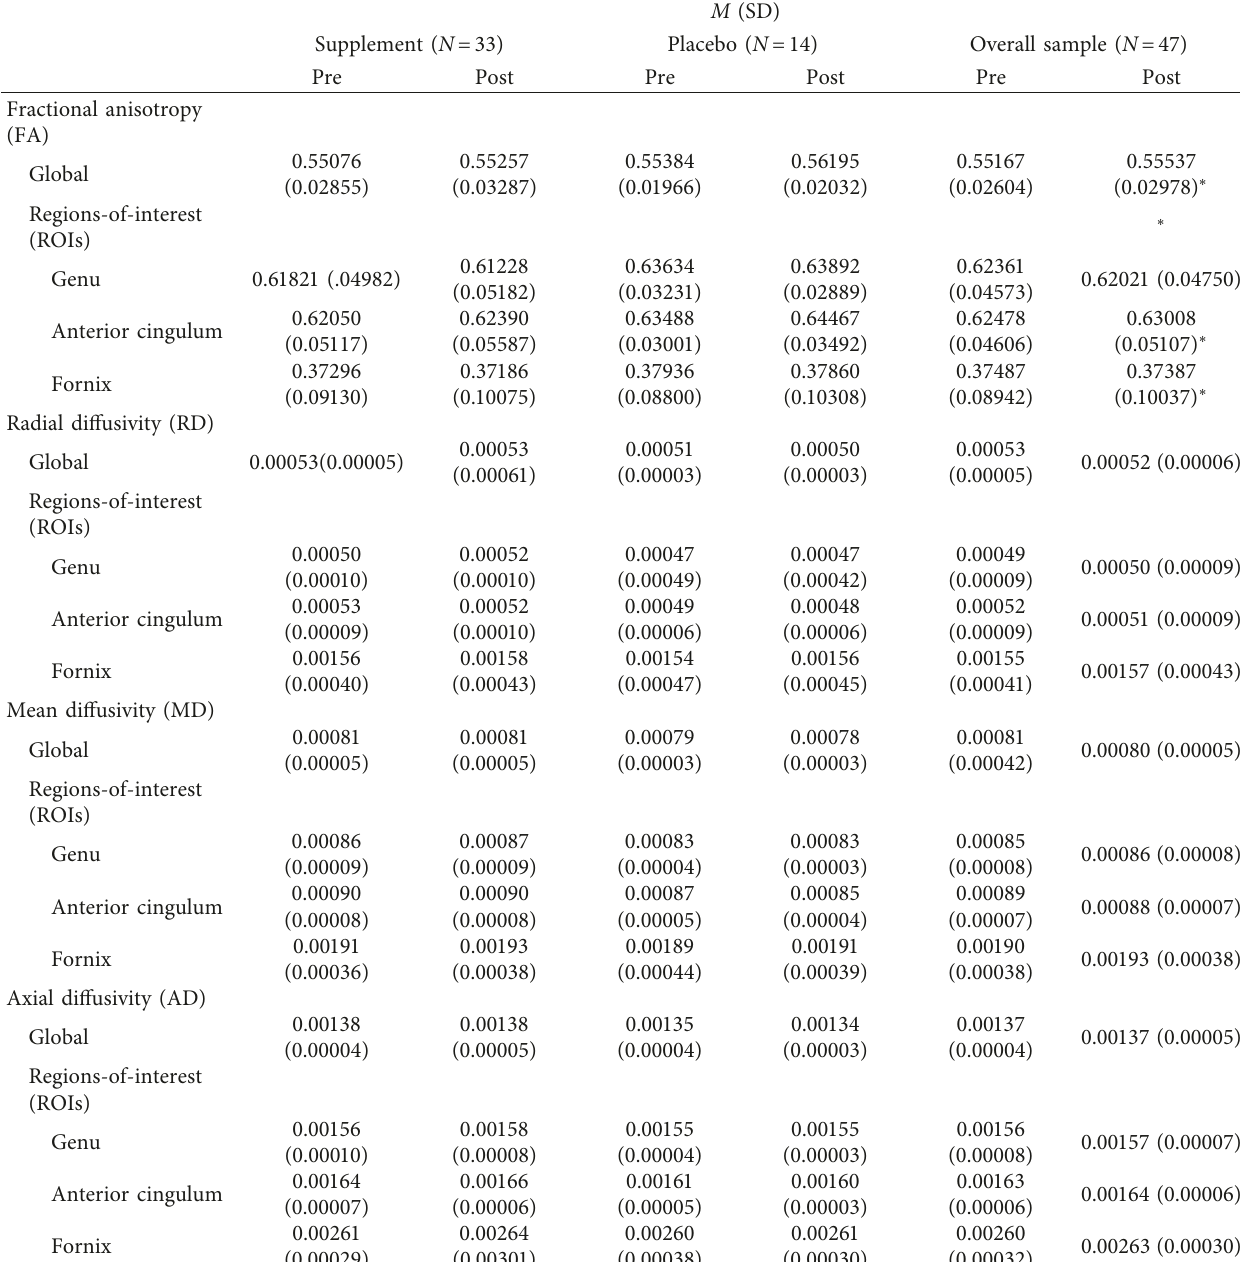
Table 3: White matter